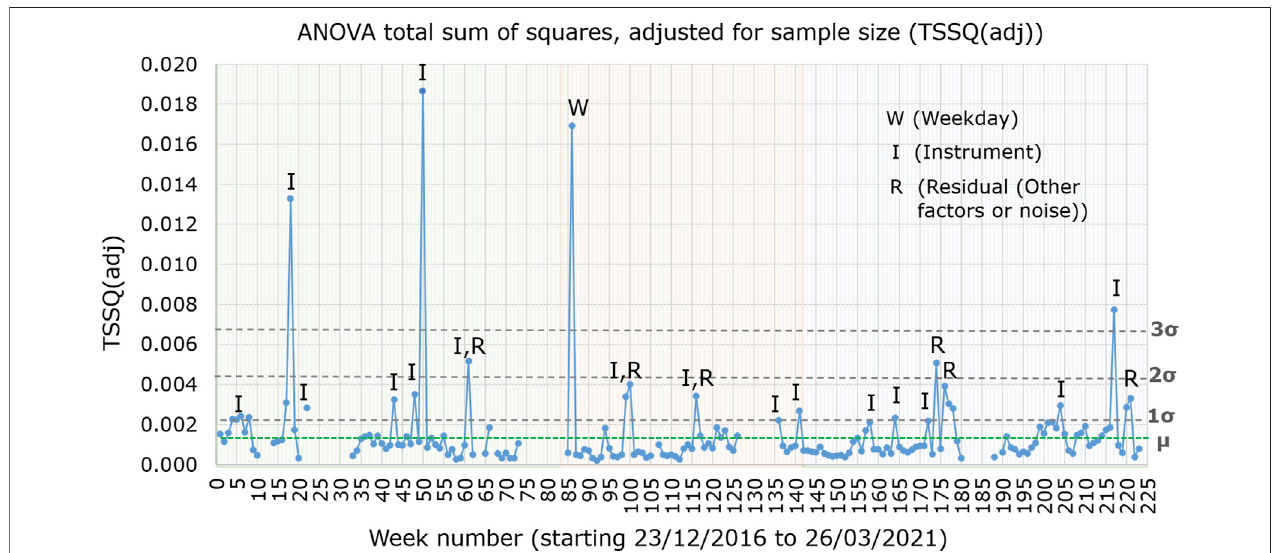
FIGURE 1 | Total sum of squares adjusted for sample size (TSSQadj), for instruments MS1, MS2, MS3, and MS4 from weeks 1 – 83 (green shaded region), for instrumentsMS3,MS4,andMS7overweeks 84 – 142(orangeshadedregion)andforinstrumentsMS3,MS4,MS7,andMS8overweeks 143 – 223(blueshadedregion). Weeks in which the TSSQ (adj) exceeded thresholds of one, two and three times the SD ( σ ) of the 177 weeks TSSQ (adj) values are labelled with the main contributing effects. The mean TSSQ (adj), labelled as µ, is represented by a green horizontal dotted line.